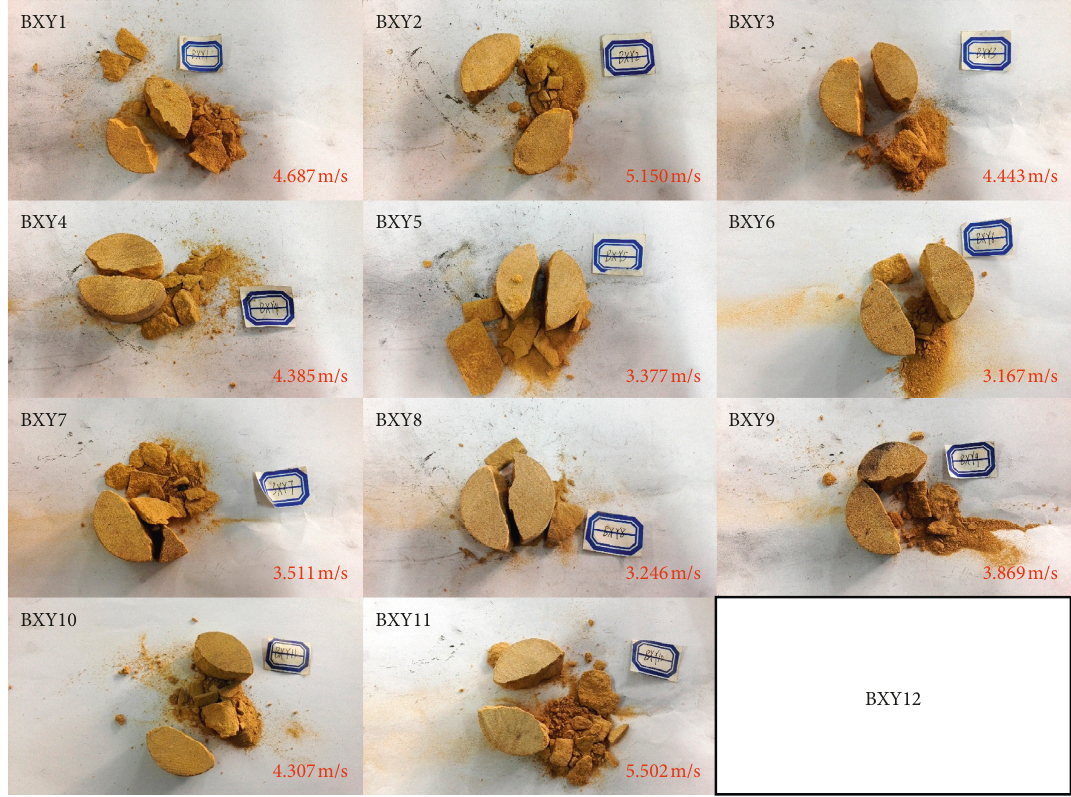
Figure 15: Image after impact